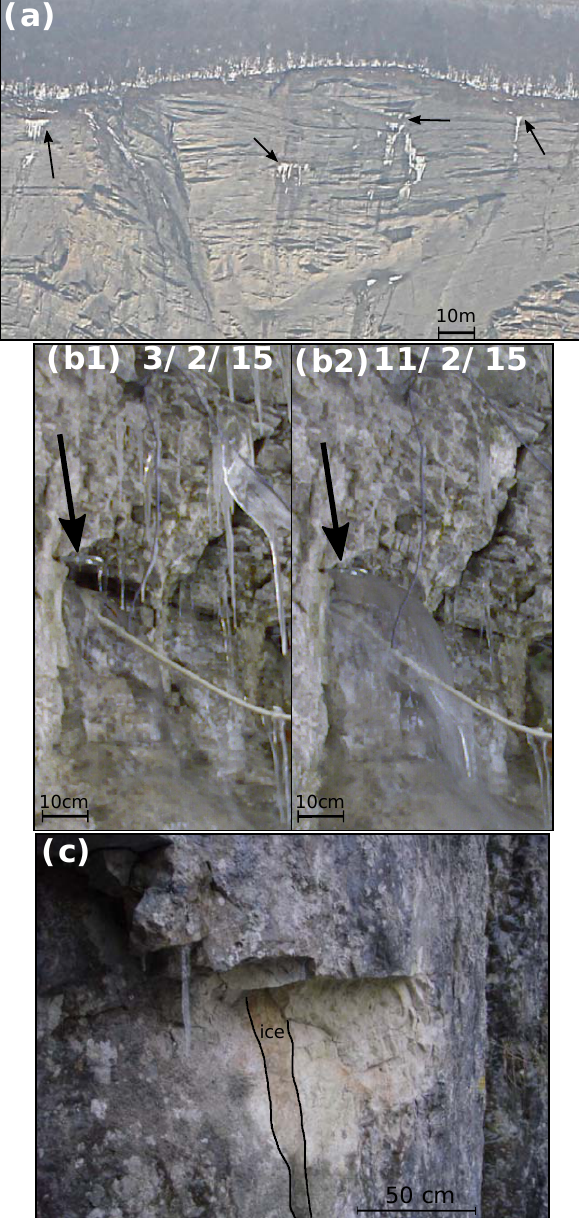
Figure 11. (a) MSE at the beginning of a thawing period. Ice formed by water coming from the forested ledge or from joints is still visible (black arrows). (b) Photographic survey of a crack in the Vercors Massif. (b1) The crack is still open. (b2) The crack is totally filled with ice. (c) Ice slab on a rockfall scar (Vercors